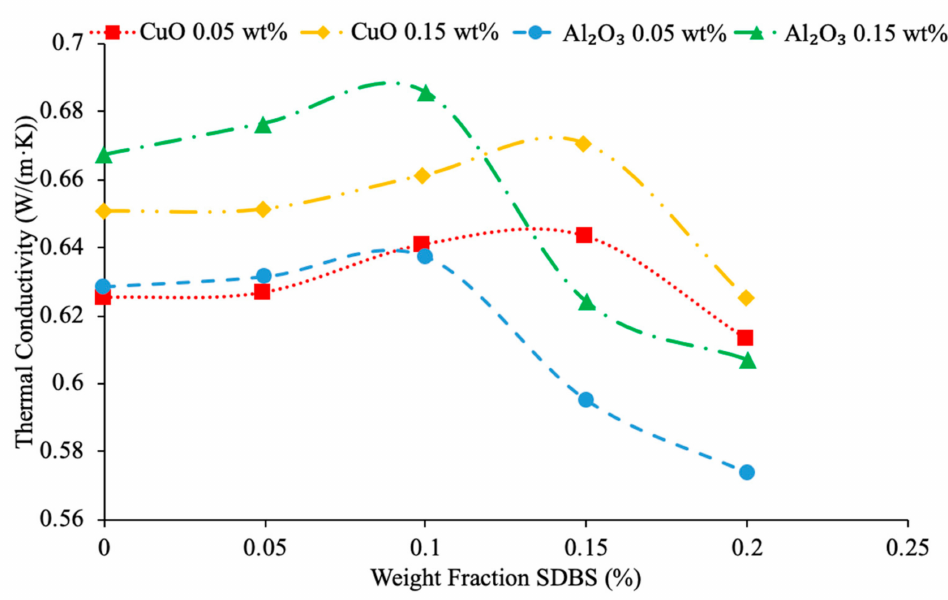
Figure 12. Thermal conductivity of water-based Al 2 O 3 and CuO nanofluids as a function of weight fraction of sodium dodecyl benzene sulfonate (SDBS) surfactant